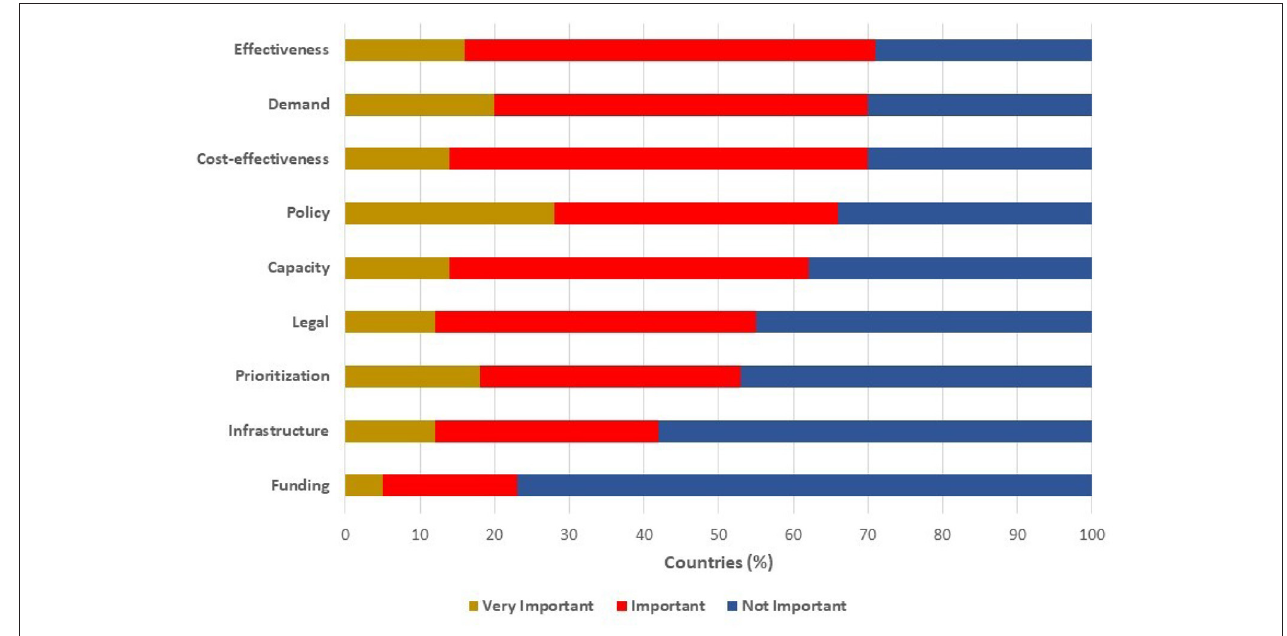
FIGURE 4 | Challenges in implementing tele-health programmes to support UHC, evaluated by level of importance.